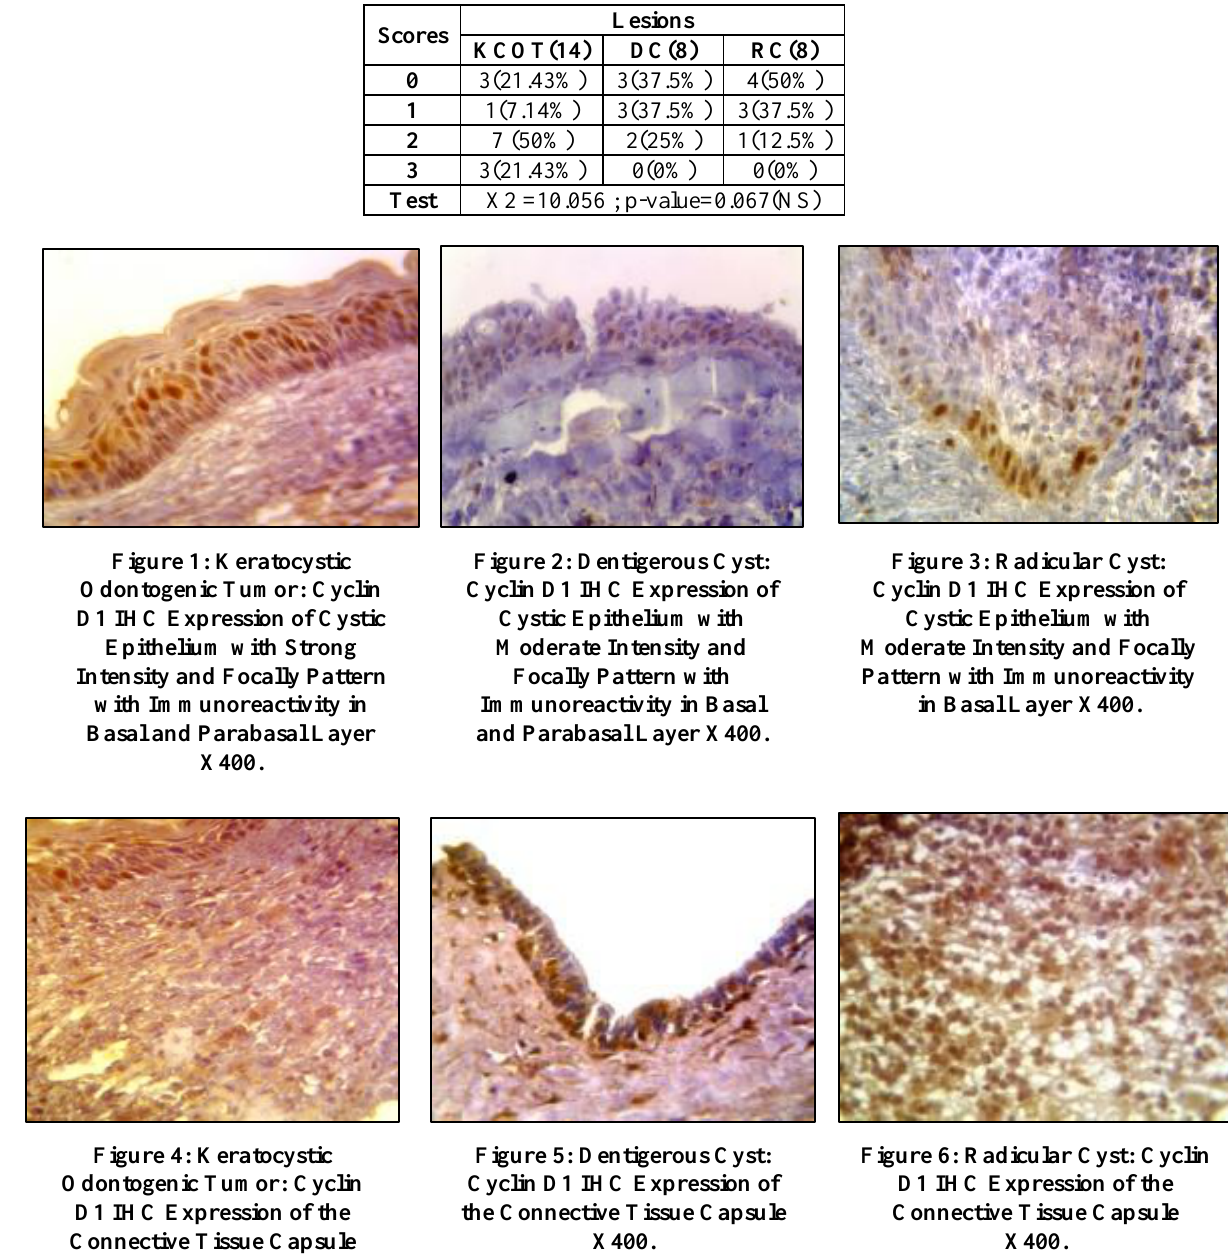
Figure 6: Radicular Cyst: Cyclin D1 IHC Expression of the Connective Tissue Capsule